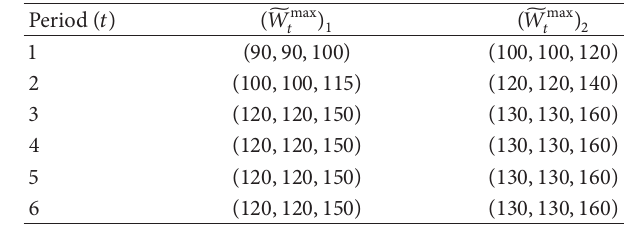
Table 8: Fuzzy maximum